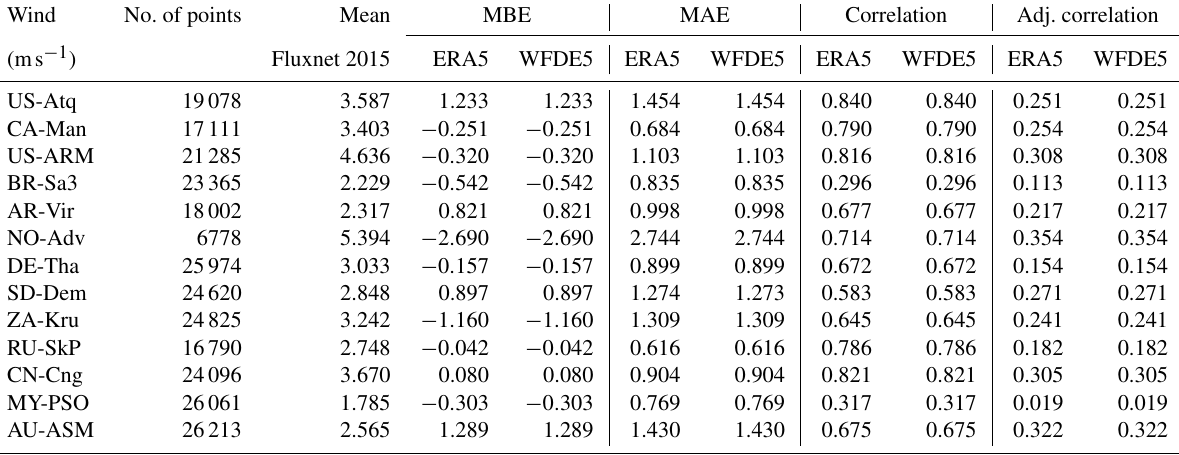
Table A4. Wind metrics for each FLUXNET2015 site: ERA5 versus FN2015 and WFDE5 versus FN2015 at hourly time steps. Wind